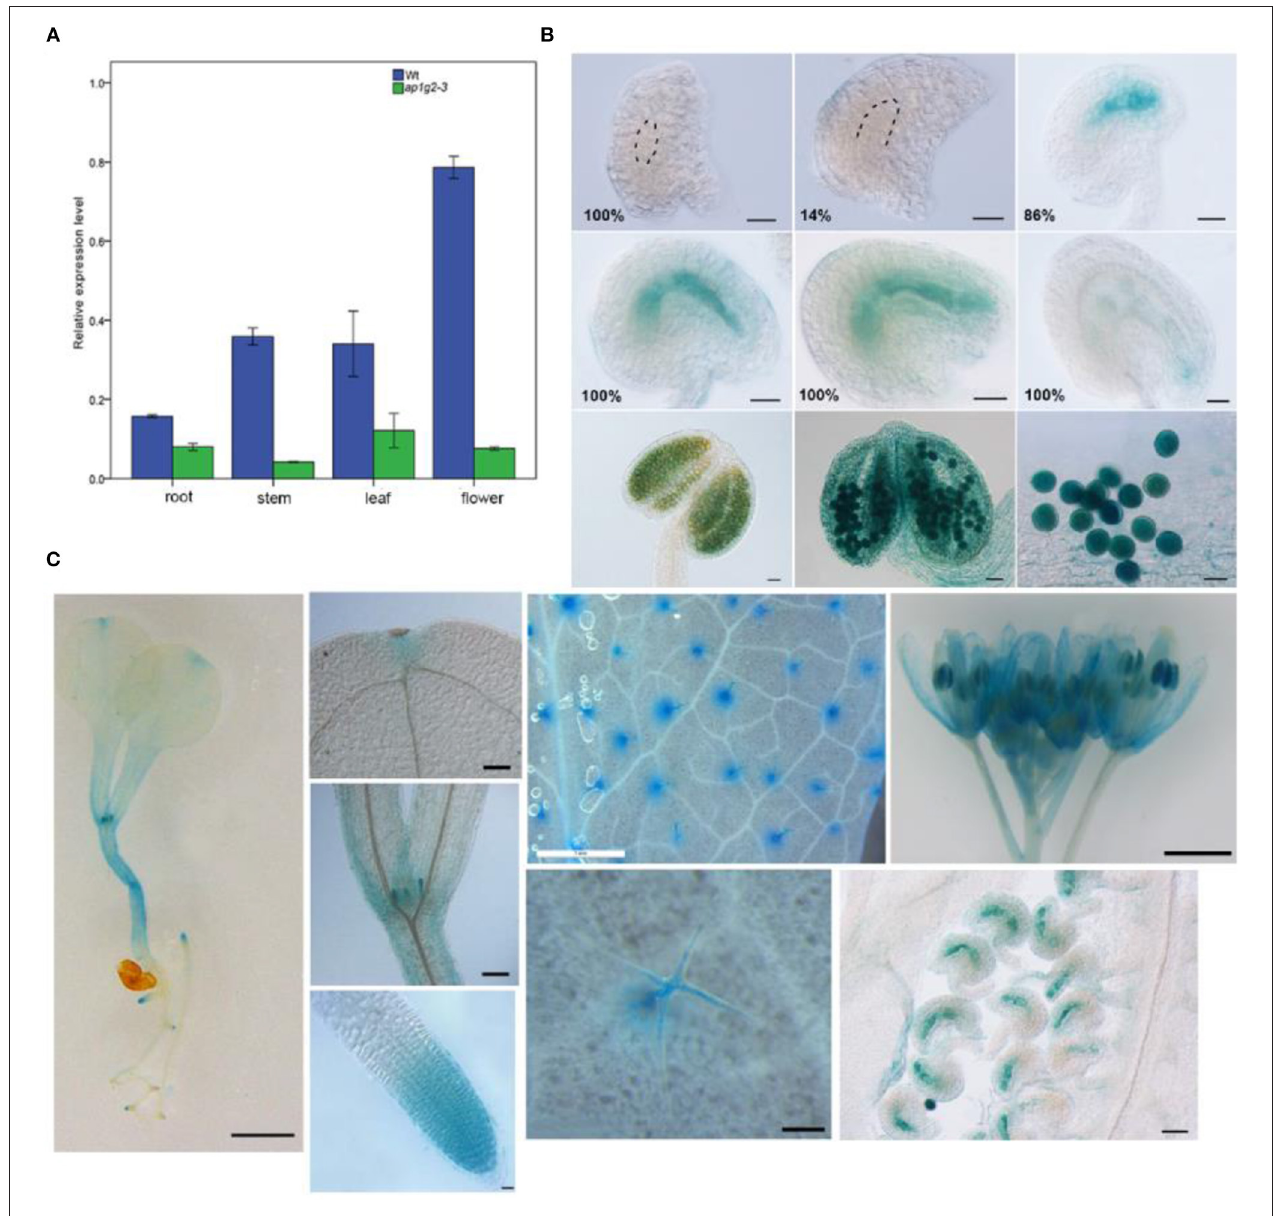
FIGURE 4 | (A) Quantitative qRT-PCR analysis of the AP1G2 gene expression. Each result was the average of three independent biological replicates. Error bars indicate standard error. (B) Activity of AP1G2 in ovules and anthers. One hundred percent of ovules containing female gamete at Stage FG1 and 14% of ovules containing a female gametophyte at FG3 were not detected GUS expression. One hundred percent ovules expressed GUS strongly at FG4 to FG7 until the process of embryogenesis. GUS staining in anthers and pollen grains. Bars = 20 µ m. (C) Pro AP1G2:GUS expression in the seedlings, leaves, and flowers. Bar = 1cm in the pictures of 8-day-old seeding, leaves, and inflorescence. Bar = 20 µ m in in the pictures of leaf primordial, apical meristem, trichomes, and ovules.